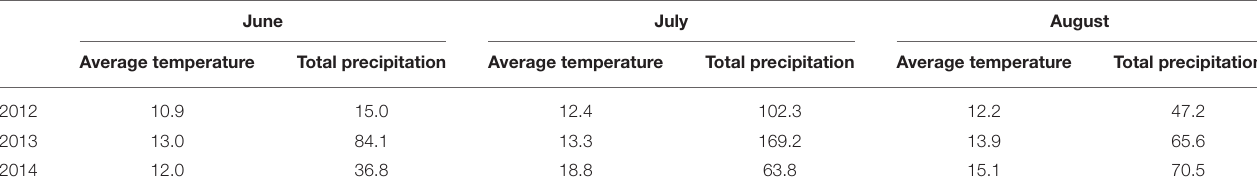
TABLE 3 | Average temperature ( ◦ C) and total precipitation (mm) in June, July, and August for 2012, 2013, and 2014 at Tjøtta weather